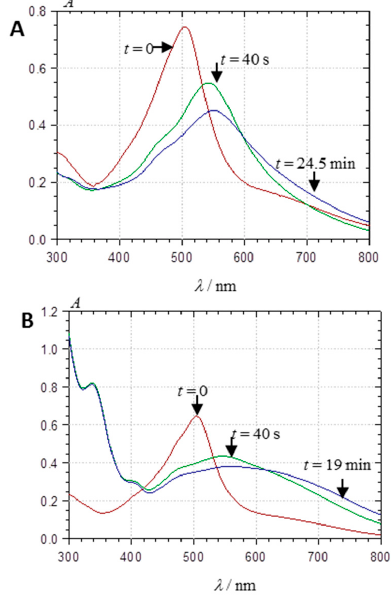
Figure 12. Visible spectra of PA1 (48.4 µM) in a pH 4.62 acetate buffer + 12% EtOH: immediately